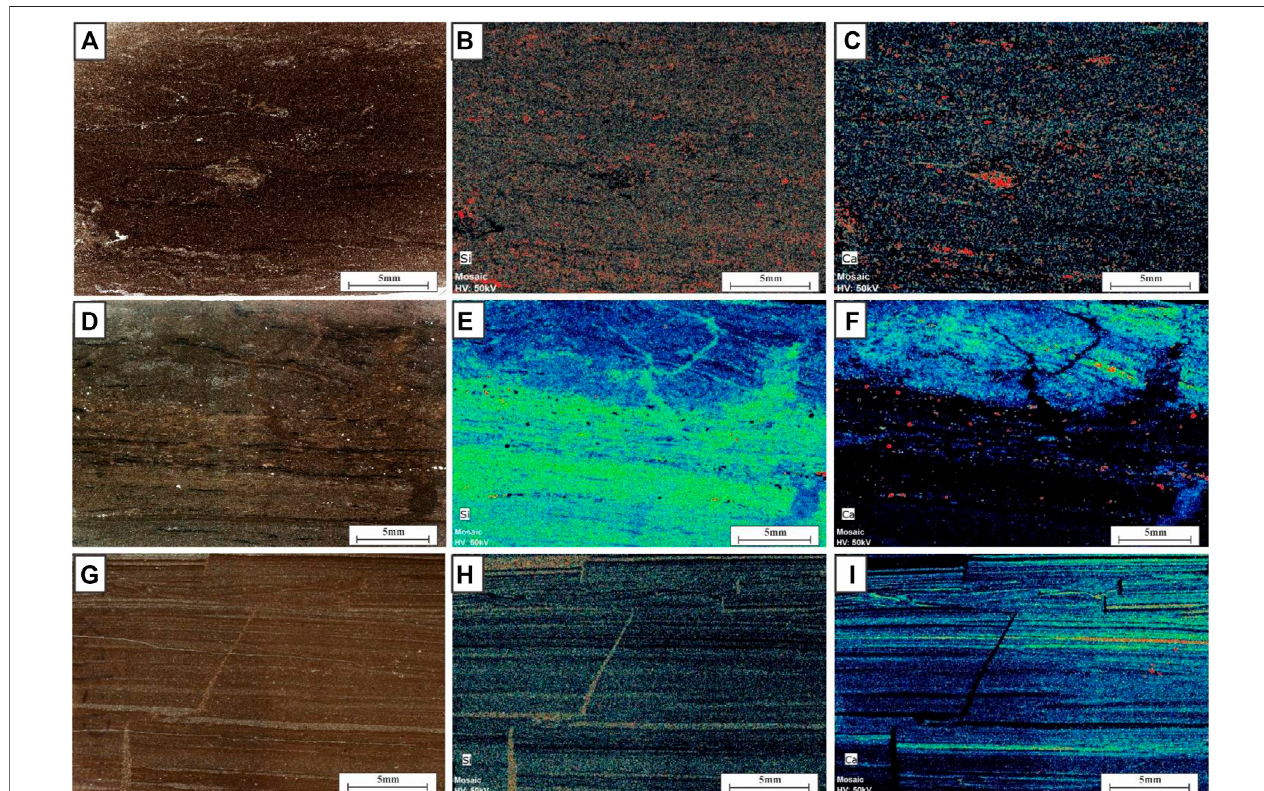
FIGURE 6 | Typical sedimentary structures of shales in the Ek 2 . Borehole locations are available in Figure 1B . (A) Thin-section photograph of massive structure sample from GD-Z well, 3862.22 m. (B) The XRF elemental maps showing the distribution and content of Si in the same sample with image (A) . (C) The XRF elemental maps showing the distribution and content of Ca in the same sample with image (A) . (D) Thin-section photograph of layered structure sample from GD-Y well, 4089.45 m. (E) The XRF elemental maps showing the distribution and content of Ca in the same sample with image (D) . (F) The XRF elemental maps showing the distribution and content of Ca in the same sample with image (D) . (G) Thin-section photograph of laminated structure sample from G-X well, 3107.33 m. (H) The XRF elementalmapsshowingthedistribution andcontentofCainthesamesamplewithimage (G) . (I) TheXRFelementalmapsshowingthedistributionandcontentofCain the same sample with image (G) .